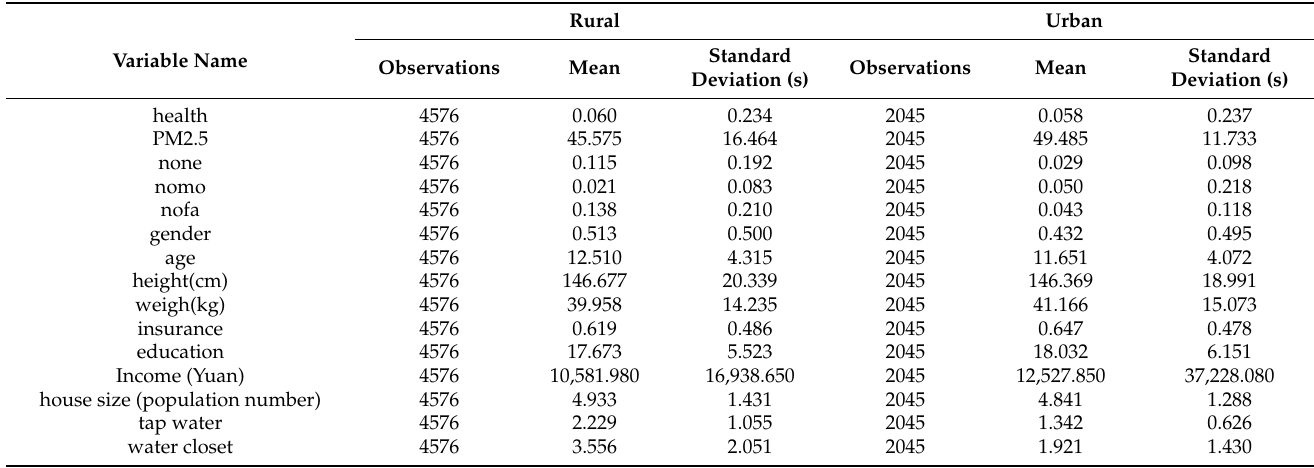
Table 1. Descriptive statistics of major